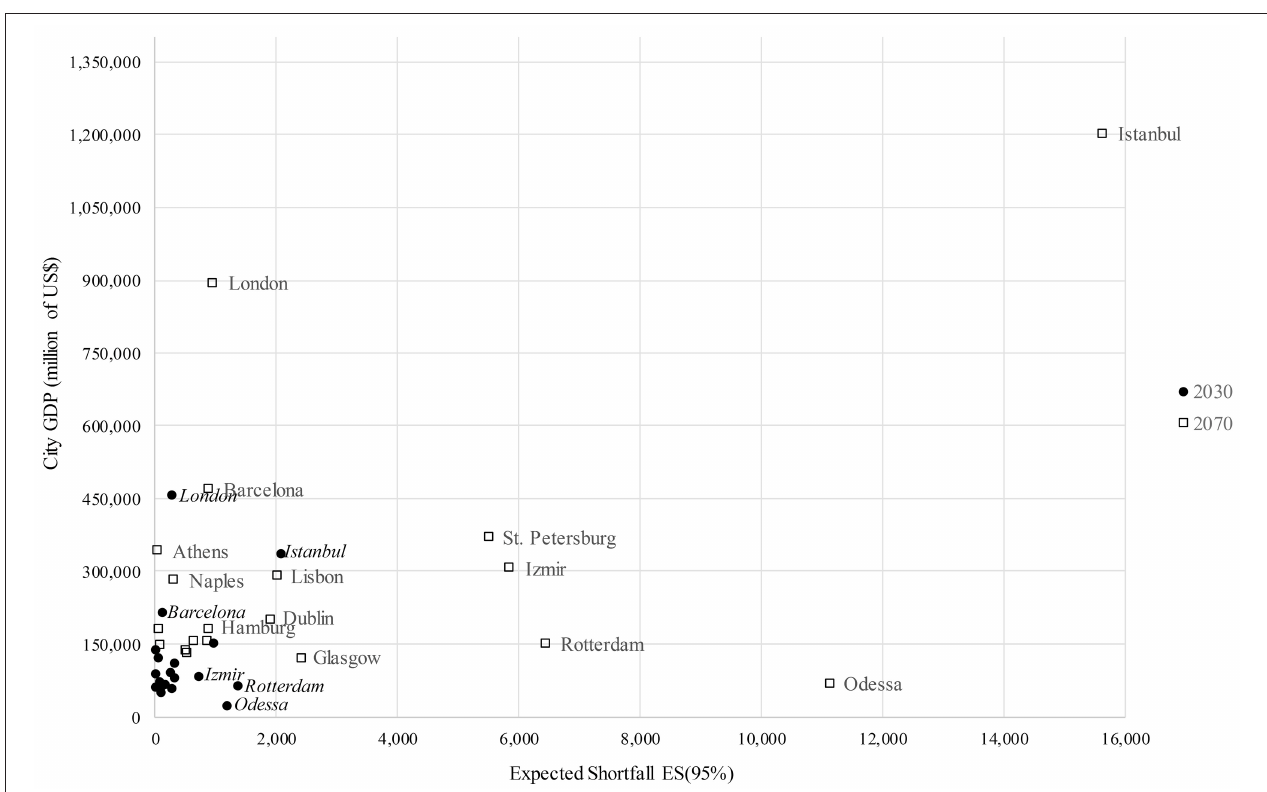
FIGURE 5 | GDP of European cities in 2030 and 2070 vs. ES (95%). under RCP8.5.